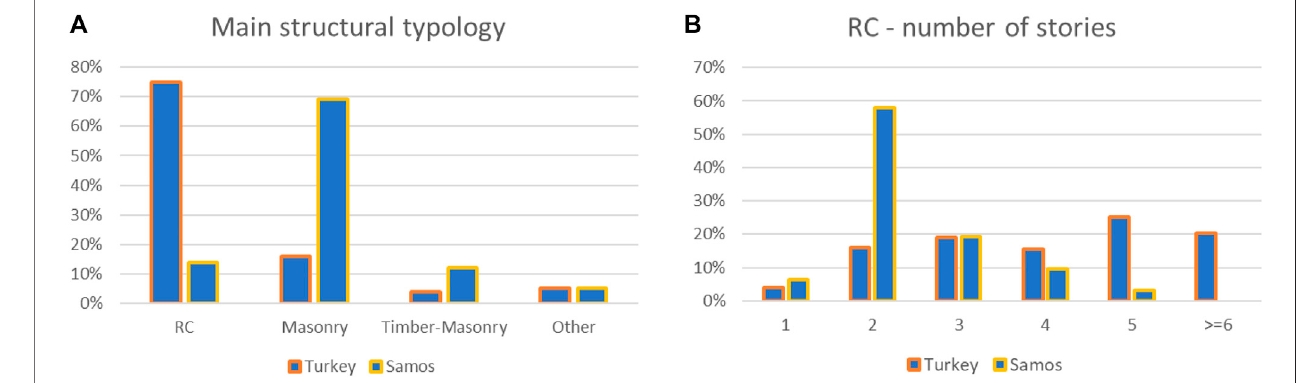
FIGURE 8 | (A) Breakdown of main structural typologies based on country (B) Distribution of number of stories in RC structures Turkey and Samos.